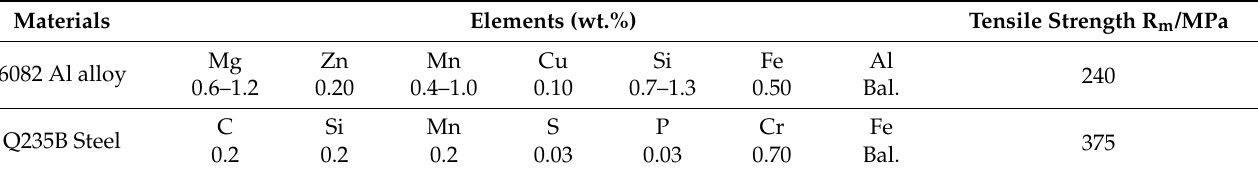
Table 1. Chemical compositions and tensile properties of base metal and flux-cored wire. Materials Elements